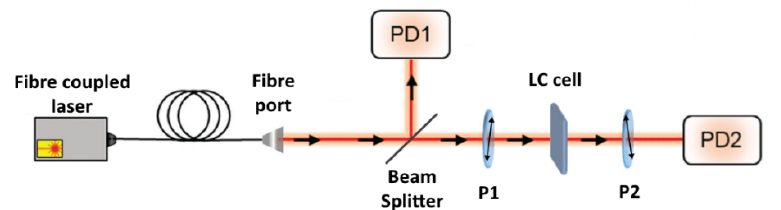
Figure 1. Experimental OMPA setup. A fibre-coupled diode laser beam is split so a portion of the light is directed to a first photodiode PD1 (reference signal), and the other part passes through the first polariser P1, the LC cell, and the second polariser P2 (analyser) before reaching the second photodiode PD2. The polariser and analyser axes are perpendicular to each other. This entire setup is enclosed to avoid any background